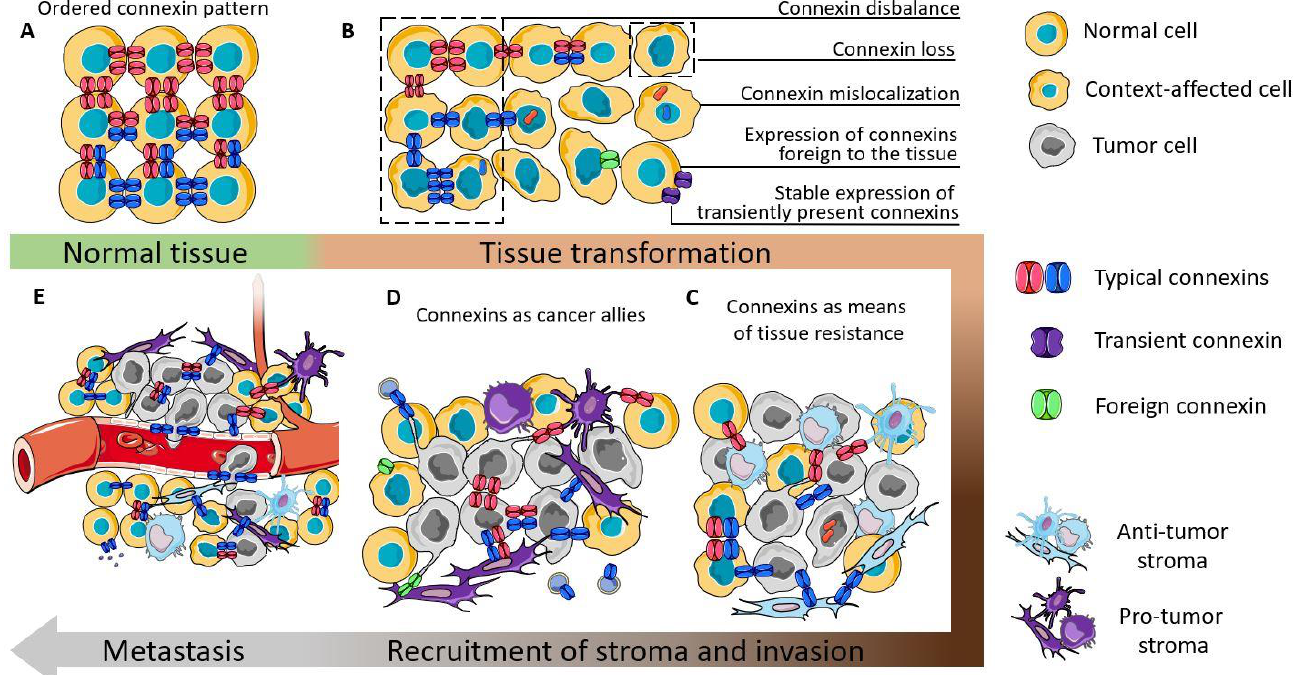
Figure 3. The proposed scheme of connexin participation in the initiation and development of cancer. ( A ) The schematic representation of the ordered connexin pattern in normal tissue. ( B ) Examples of connexin dysregulation which can contribute to the disruption of tissue orderliness. ( C ) Connexins as integrators of tumor parenchyma with the stromal cells which suppress tumor aggressiveness. ( D ) Connexins as integrators of tumor tissue, contributing to its progression. ( E ) Connexins as a means to perform and facilitate metastasis.